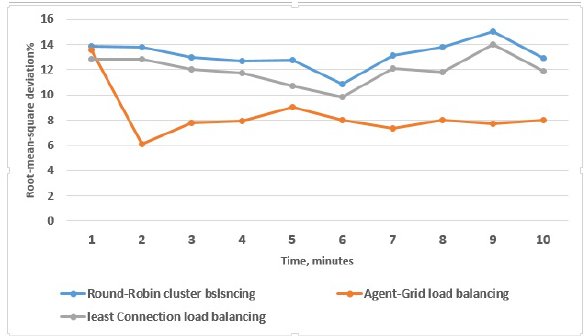
Figure 5: Root-mean-square deviation of node